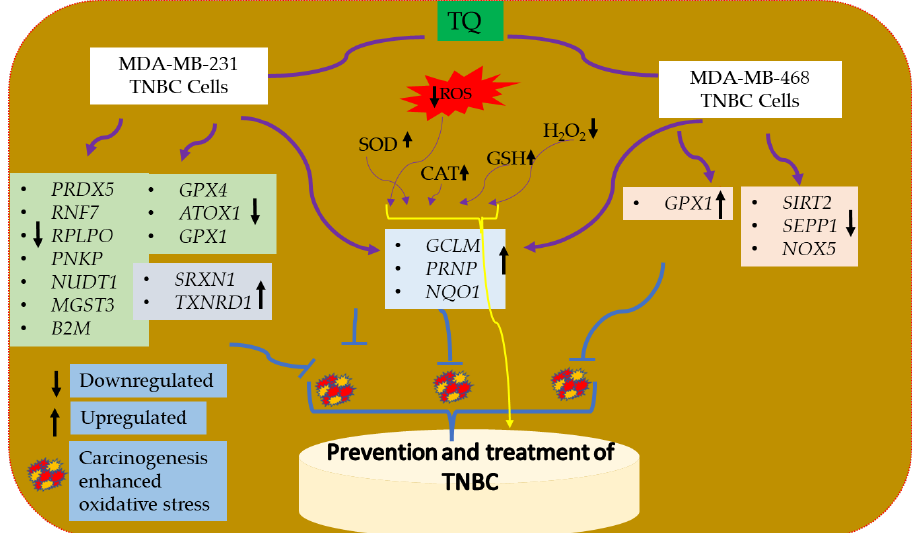
Figure 13. The effect of TQ on oxidative stress-antioxidant defense system gene expression in MDA-MB-231 and MDA-MB-468 TNBC cells. TQ downregulates and upregulates important cytoprotective genes. The consequence of these effects would be useful in preventing and treating TNBC. The black arrow indicates that genes are either upregulated or downregulated in TNBC cells. Altogether, it may be suggested to utilize TQ as an agent for the prevention and treatment of TNBC.